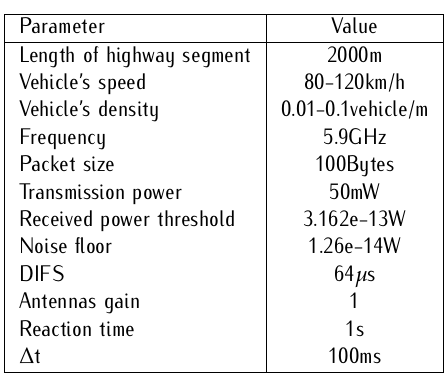
Table 1. Value of parameters used in Simulation